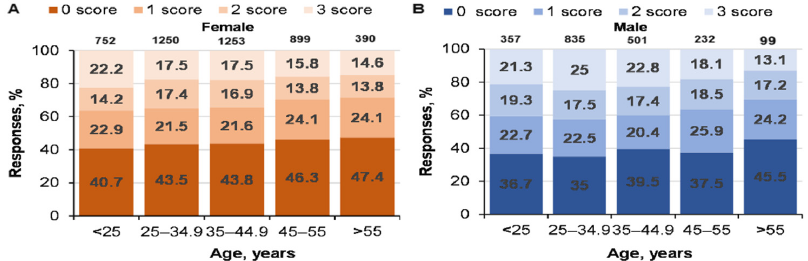
top of the column is the number of participants. (( A )—women CRT responses % and age; ( B )—men CRT responses % and age).